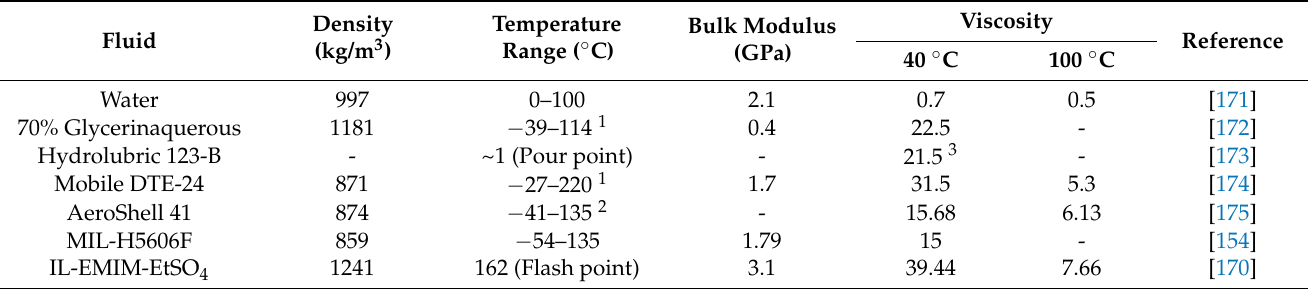
Table 6. Properties of typical working